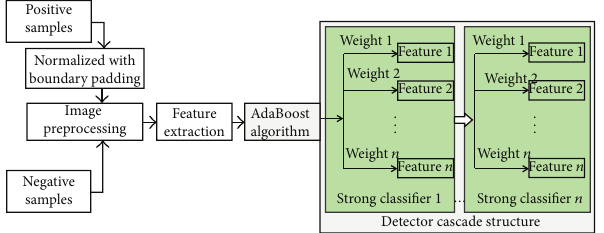
Figure 4: Structure for the offline training